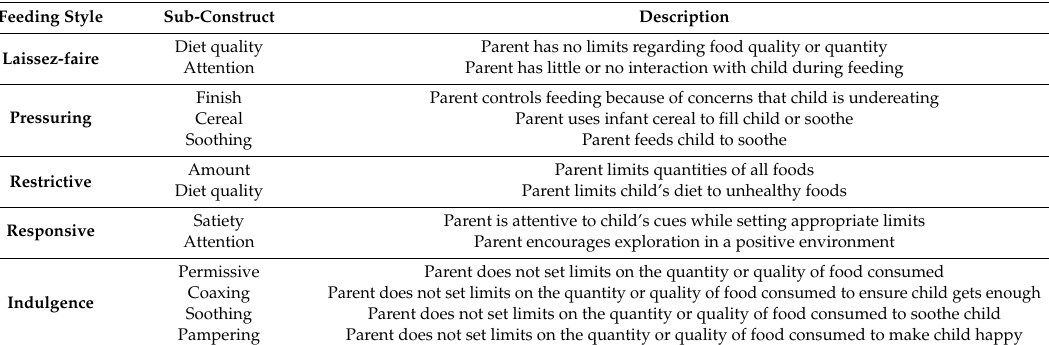
Table 1. Infant Feeding Style Questionnaire (IFSQ) structure and